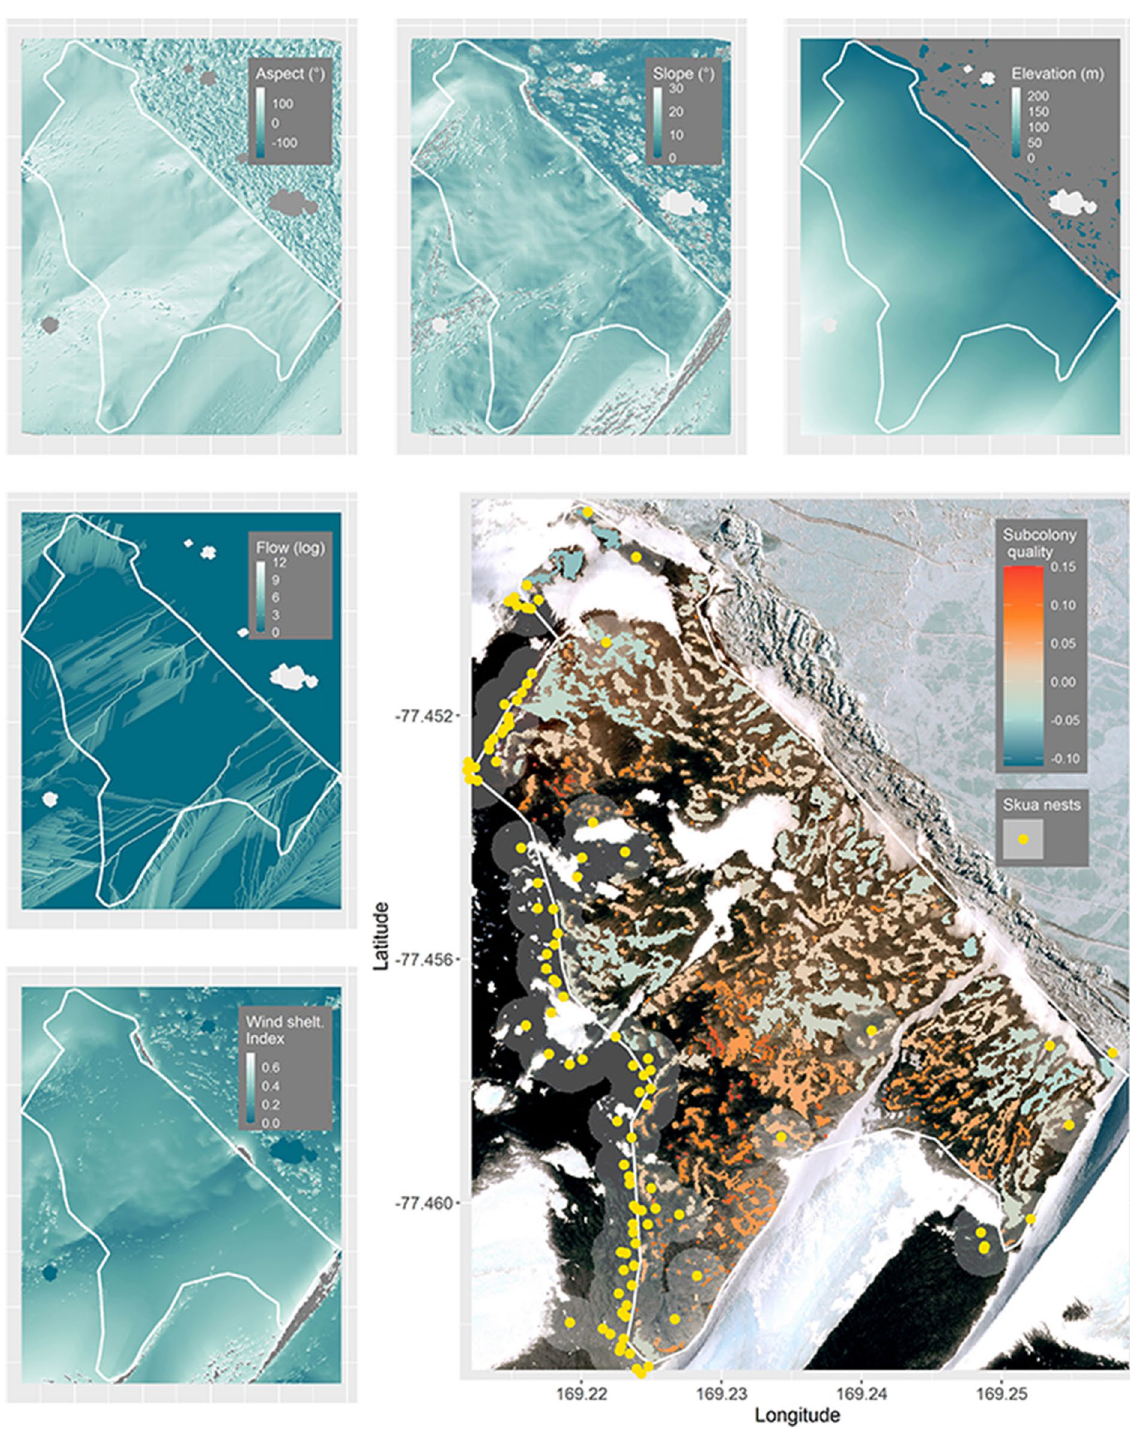
Figure 5. Spatial habitat covariate layers and predicted subcolony quality at Cape Crozier, Ross Island, Antarctica (background WorldView-3 satellite image, November 20, 2014, copyright 2014 DigitalGlobe, NextView License). Positive values (orange) indicate above average subcolony quality and negative values (teal) indicate below average subcolony quality relative to the mean at Cape Crozier. Yellow points indicate locations of skua nests included in the model and grey circles show the 50 m radius used to indicate skua nest